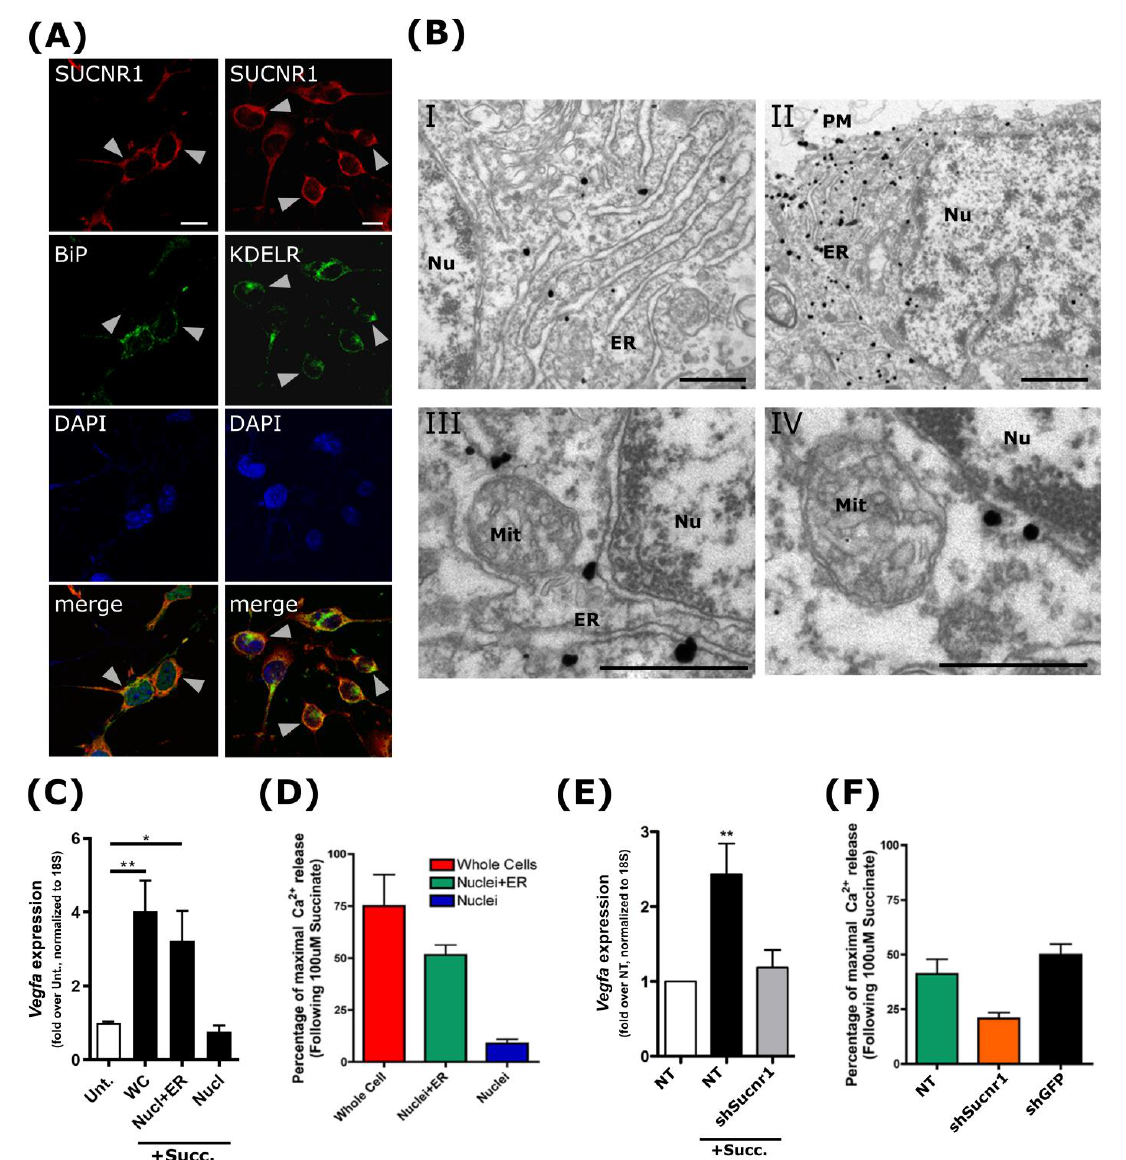
Figure 1. ER-localized SUCNR1 is functional. ( A ) Endogenous SUCNR1 in RGC cells colocalized with ER markers,: KDEL receptor and BiP; arrows point to the regions of highest colocalization. Scale bars: 20 µ m. ( B ) In situ ultrastructural ER localization of SUCNR1 in rat parietal cortex tissue sections by electron microscopy, where immunogold-labeled antibodies against SUCNR1 could be found in ER folds. PM: plasma membrane; Nu: nuclei; ER: endoplasmic reticulum; Mit: mitochondria. Scale bars: ( I , II ): 1 µ m; ( III , IV ): 400 nm. ( C ) RT-qPCR on isolated fractions of RGC-5 cells reveals that a 4 h stimulation with 100 µ M succinate induced Vegfa expression. Absence of the ER impaired this induction upon succinate stimulation (filled bars) compared with unstimulated samples (Unt.: empty bar). WC: whole cells; Nucl + ER: fraction; Nucl: nuclear fraction only. ( D ) Ca 2+ release on isolated RGC fractions containing ER or not. Calcium release was measured for 30 min, and is represented as fold change compared with the ionomycin-treated sample. Ca 2+ release was not observed in absence of the ER. ( E ) Isolated Nucl + ER fractions of RGC cells expressing a shRNA against SUCNR1 did not express Vegfa after 100 µ M succinate stimulation for 4 h. NT: nontransfected. ( F ) In isolated Nucl + ER fractions, Ca 2+ release upon succinate treatment was lower in shSUCNR1 cells than in shGFP control cells. Calcium release was measured as in ( D ). *, **, p < 0.05, 0.01compared with corresponding controls,